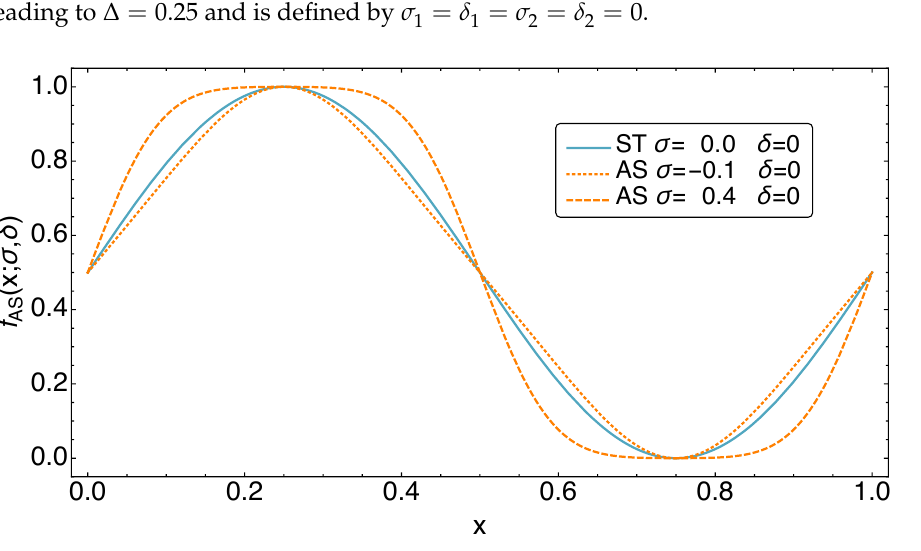
( x ; σ , δ ) of the AS motion class for three values of the shape Figure 2. The defining function f AS parameter σ compared to standard sinusoidal motion (ST) at σ = 0. Note that f AS ( x ; σ , δ ) is periodic with period 1 as a function of its independent variable x . For values σ < 0, the shape of the motion is shifted to be more triangular, while for values σ > 0, the shape becomes increasingly square-like.